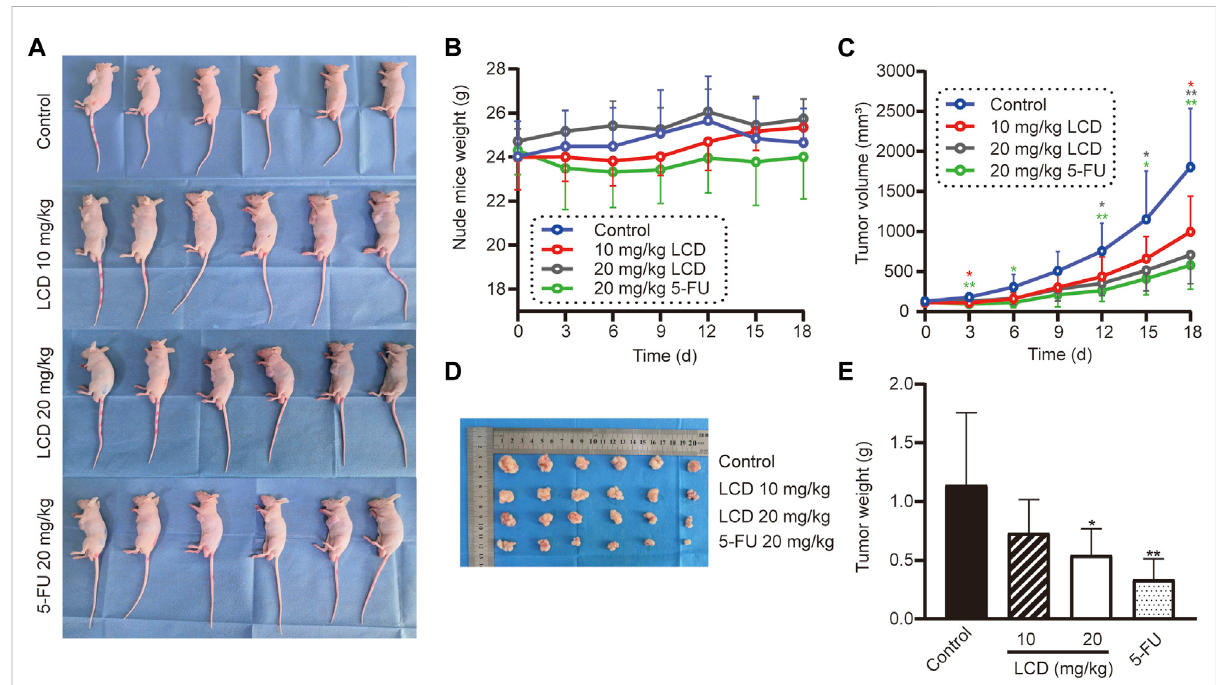
FIGURE 4 Licoricidin prevented MGC-803 cell xenografted tumor growth in vivo. (A) Models of the MGC-803 cell xenografted tumor in nude mice, divided into four groups ( n = 6). After the xenografted tumor models were established successfully, we administered an intraperitoneal injection of normal saline, licoricidin 10 mg/kg, licoricidin 20 mg/kg, or 5- fl uorouracil 20 mg/kg once every 2 days in the corresponding groups. Nude mouse weight (B) and tumor volume (C) were measured once every 3 days. The course of treatment was 15 days in total, and then all mice were euthanized after 3 days. (D) Macroscopic appearance of xenografted tumors. (E) Tumors were weighed after they were removed from the bodies. Values are expressed as mean ± SD, * p < 0.05 and ** p < 0.01. LCD, licoricidin. 5-FU, 5- fl